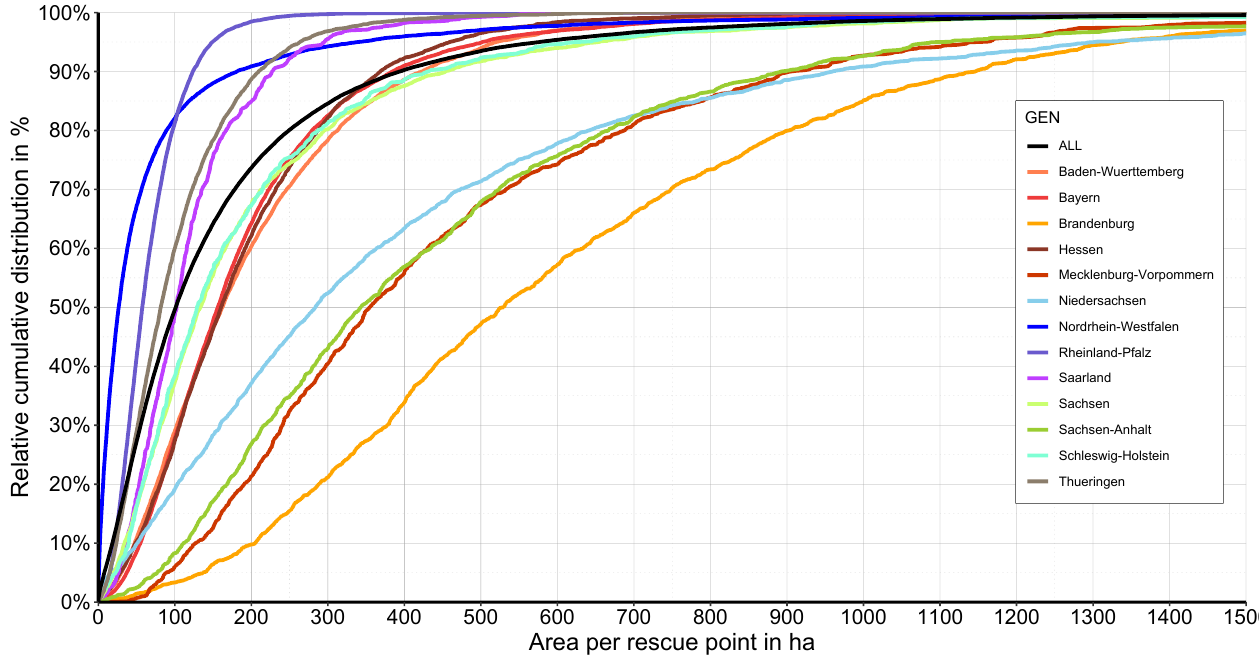
Figure 10. Relative cumulative distribution of the Euclidean distance of the related area per rescue point for the different federal states and the federal level. Area per rescue point in ha calculated using Thiessen